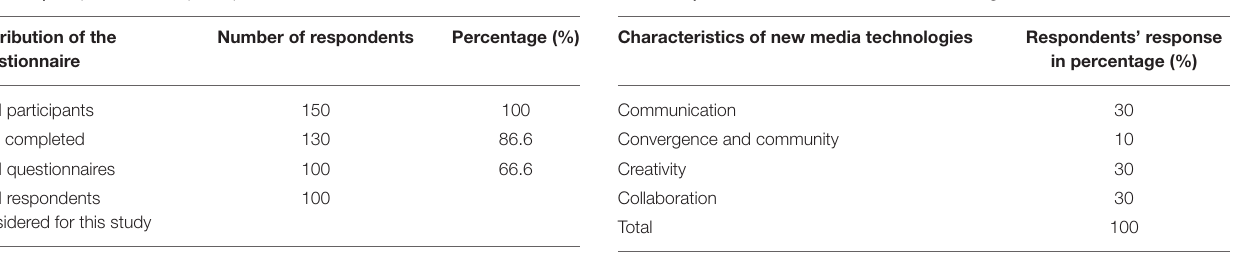
TABLE 4 | Characteristics of new media technologies.